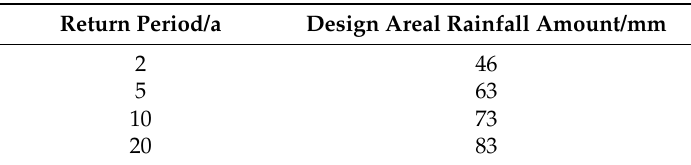
Table 2. Summary of mode hyetograph types in Yangpu District.